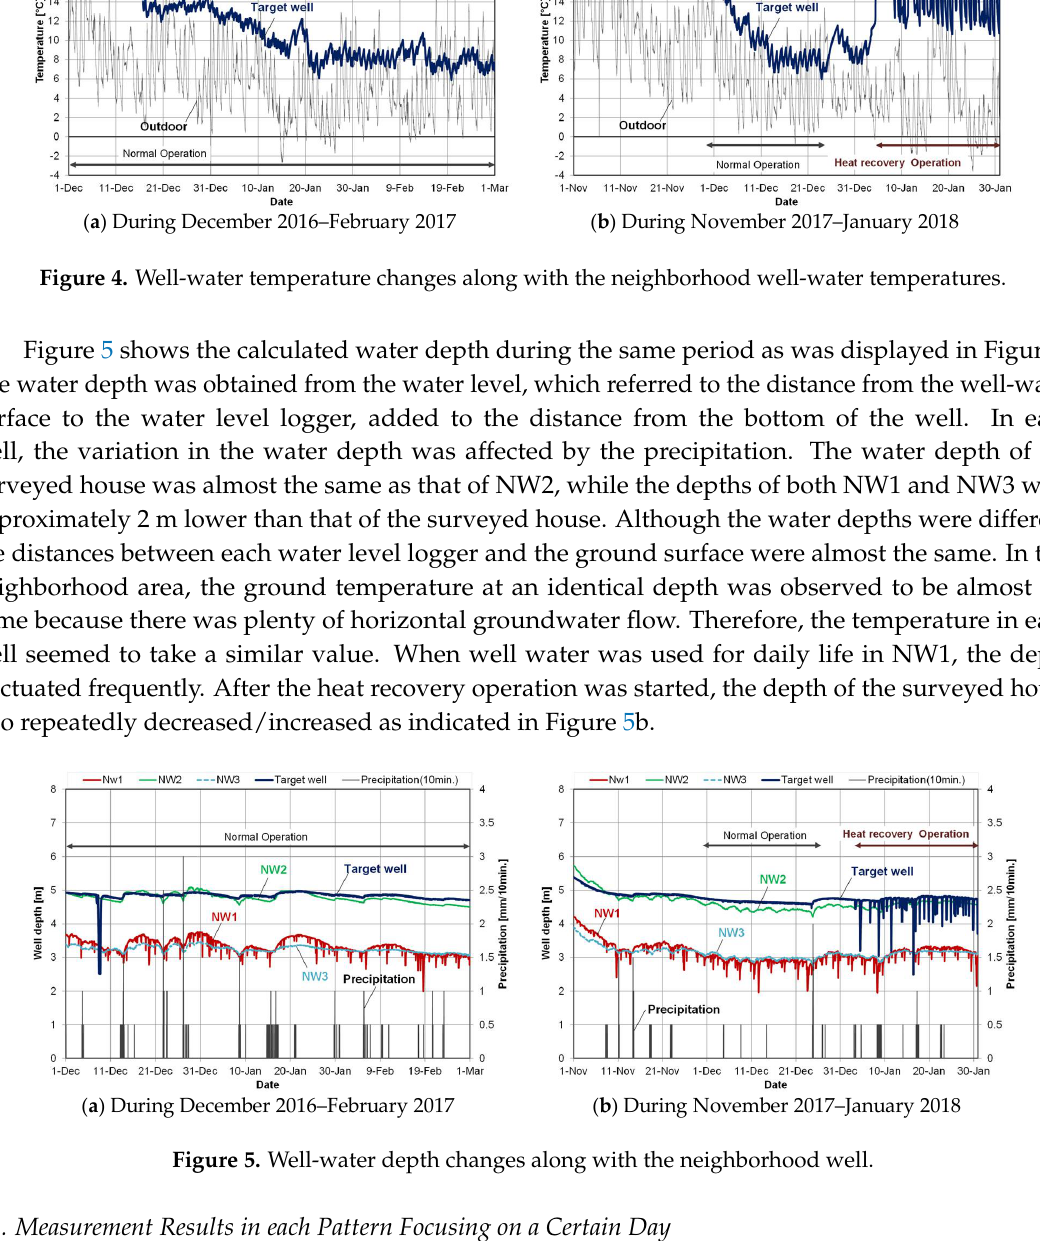
Figure 5. Well-water depth changes along with the neighborhood